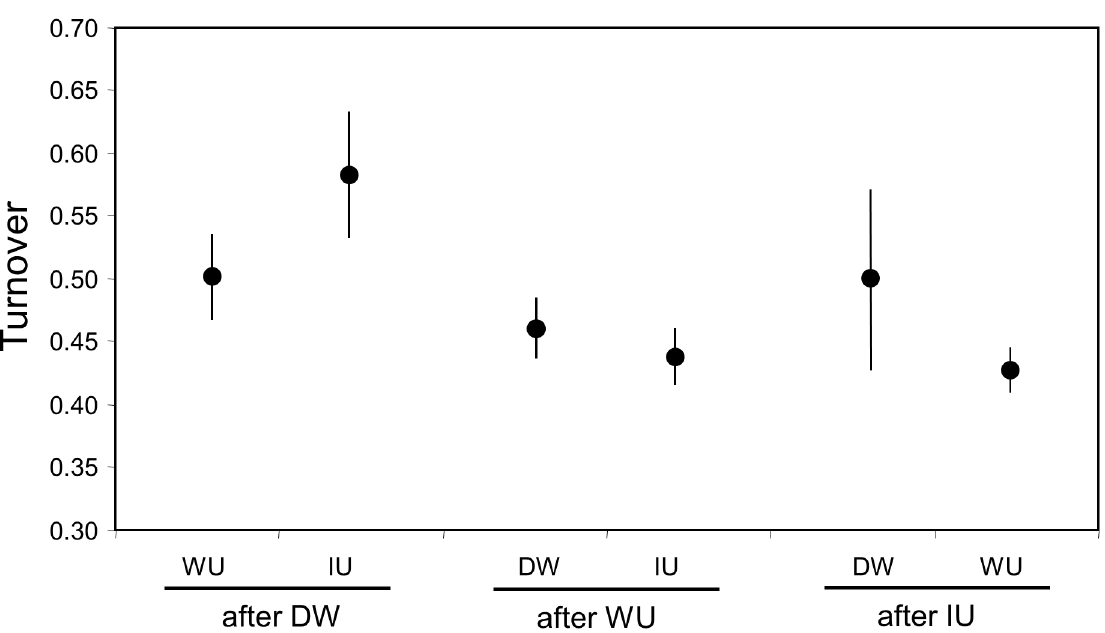
Fig 7. Turnover of the phytoplankton assemblage for changes in the upwelling conditions. Values shown represent the averageturnover (20 samples for IU-WU; 18 samples for D-WU; 19 samples for WU-IU; 5 samples for D-IU; 19 samples for WU-D; 4 samples for IU-D) and respective standard error for the six possiblealterationsin the upwelling.IU: intenseupwelling; WU: weak upwelling;D: downwelling.